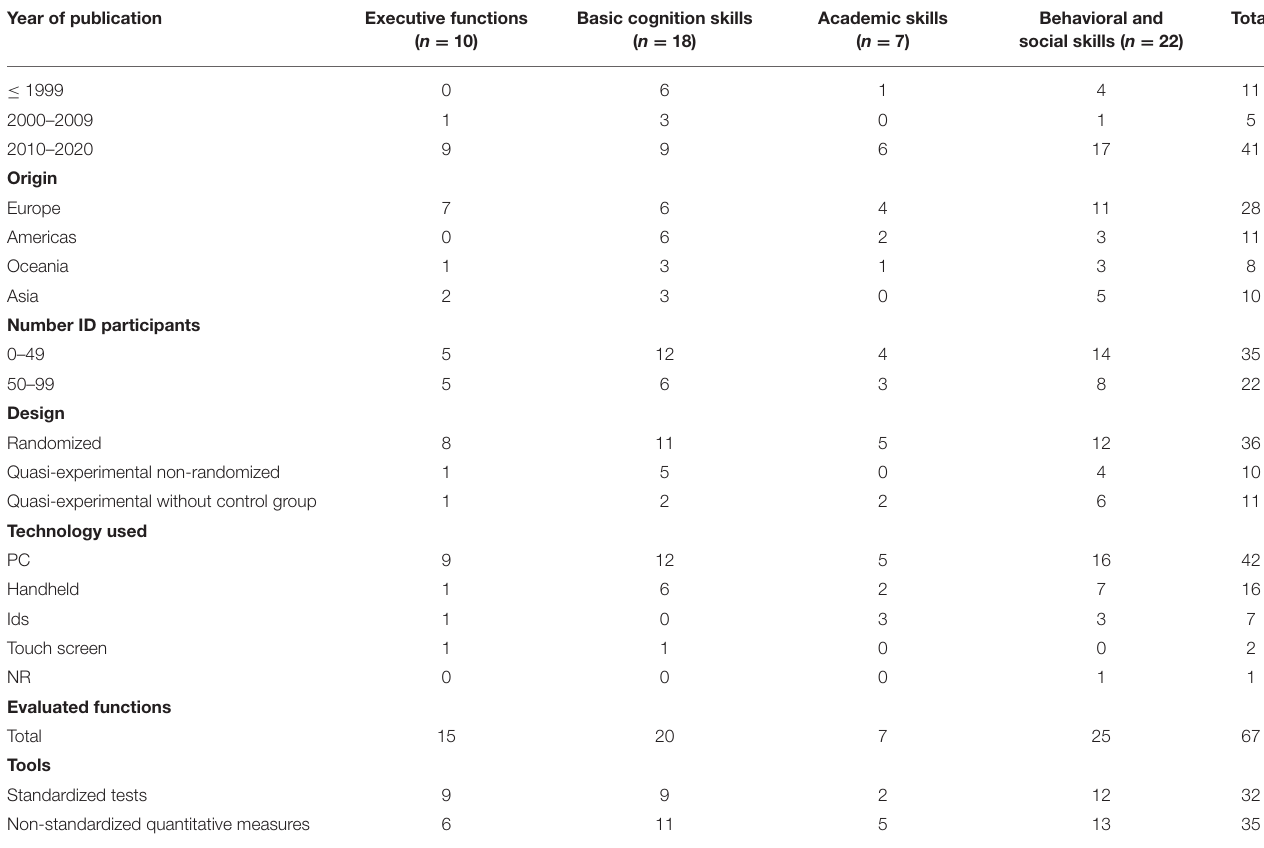
TABLE 1 | Study characteristics according to psychological